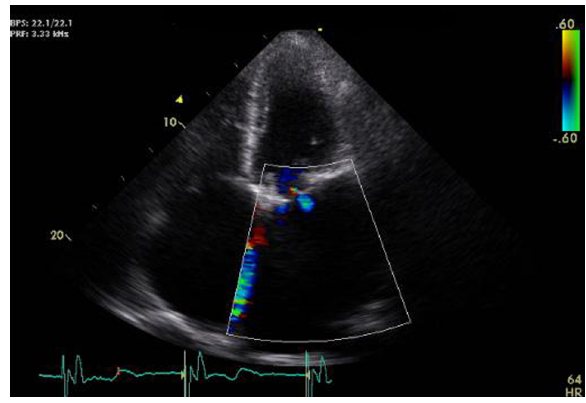
Figure 4 . Postoperative echocardiogram with mitral valve replace- ment (Labcor 31